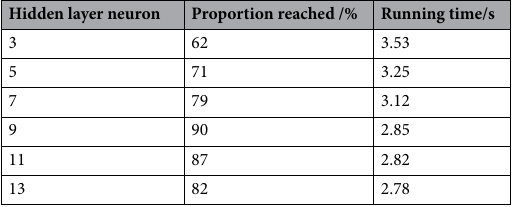
Table 3. Comparison of the number of neurons in different hidden layers.